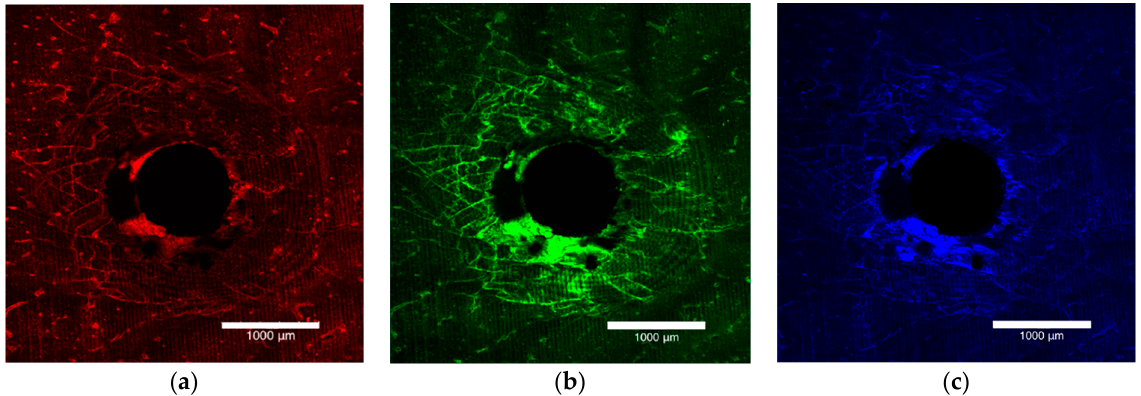
Figure 1. Laser confocal microscope images depicting the entry surface of a 2.0 mm thickness bone block specimen. ( a ) The orange flecks represent the surface preparation damage, ( b ) the green stain highlights the damage caused by insertion of the OMI and ( c ) the blue stain outlines the damage caused by removal of the OMI.